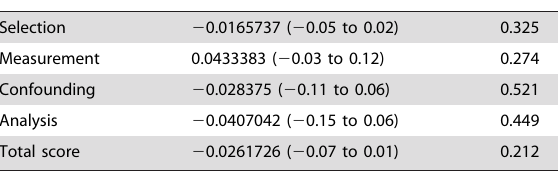
Table 3. Results of meta-regression analysis of OR for HPV- OSCC association on scores from quality domains of all studies included in the meta-analysis.